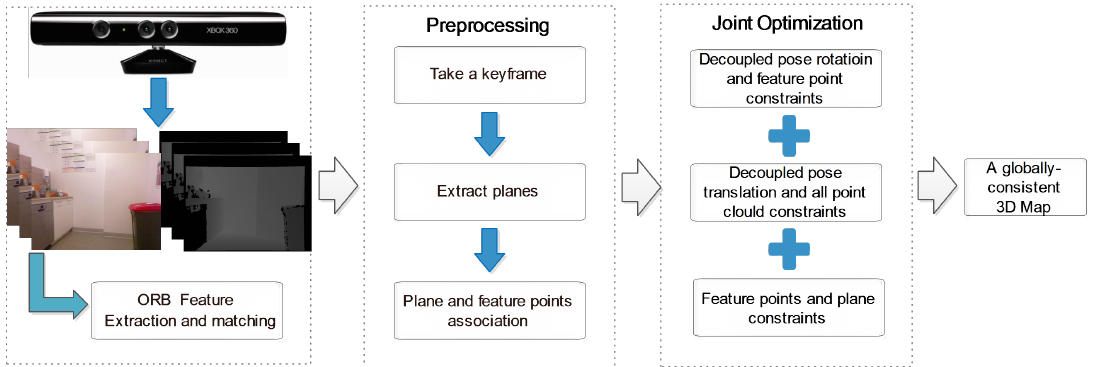
Figure 1. Overview of the proposed